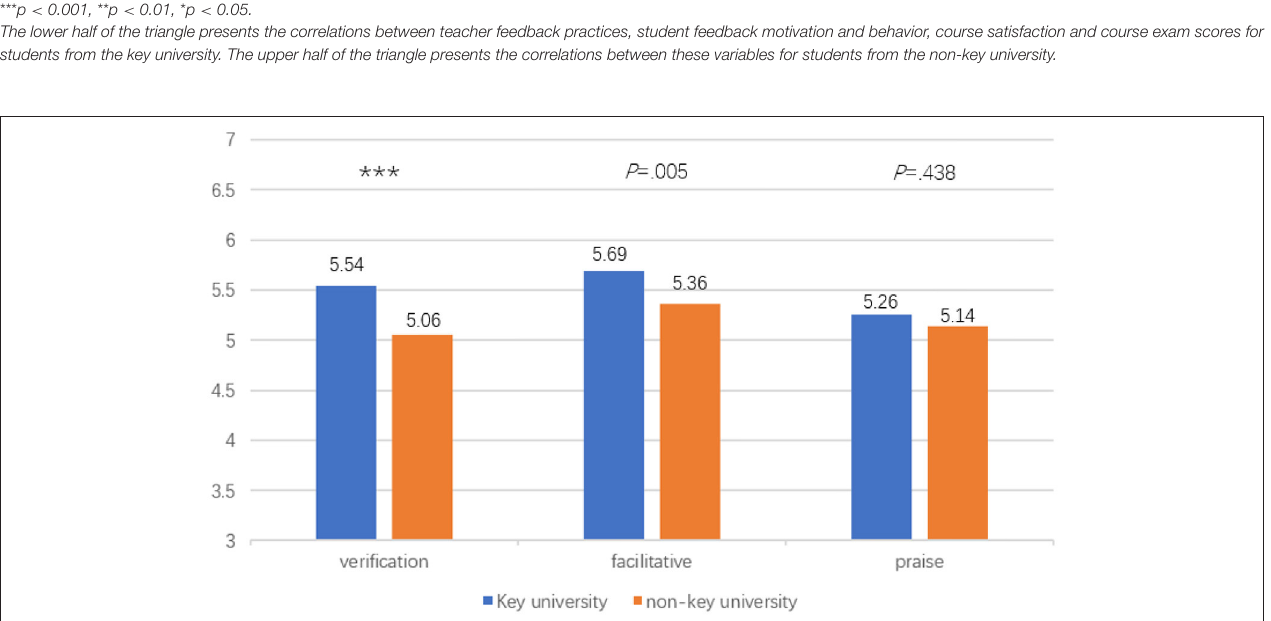
Frontiers in Psychology |